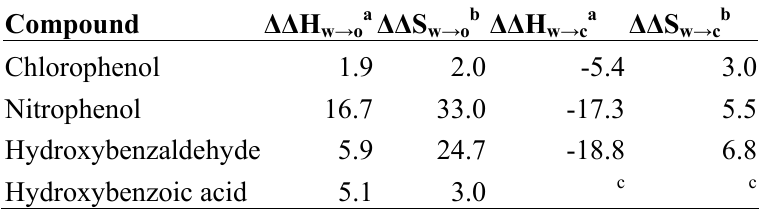
Differences between 2- and 4-substituted phenols of enthalpies ( ∆∆ H) and entropies ( ∆∆ S) of transfer from water to octanol and from water to